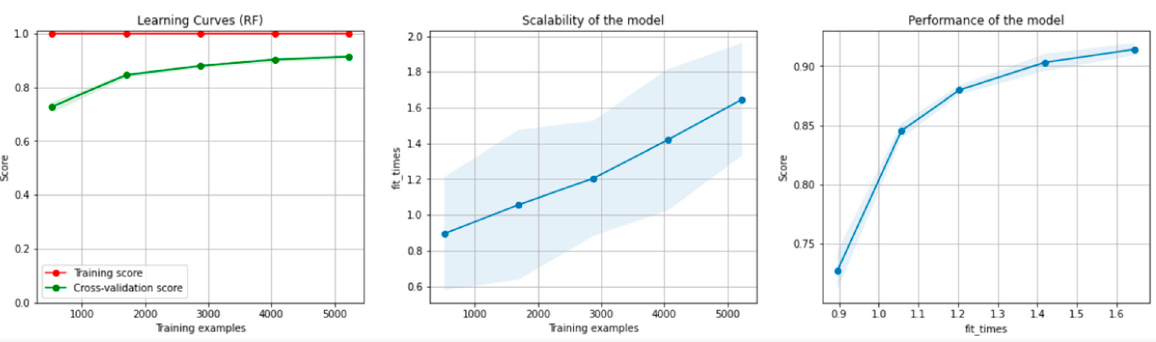
Figure 14. Learning curves, model scalability and model performance for the GBT algorithm, for the overlapping dataset.